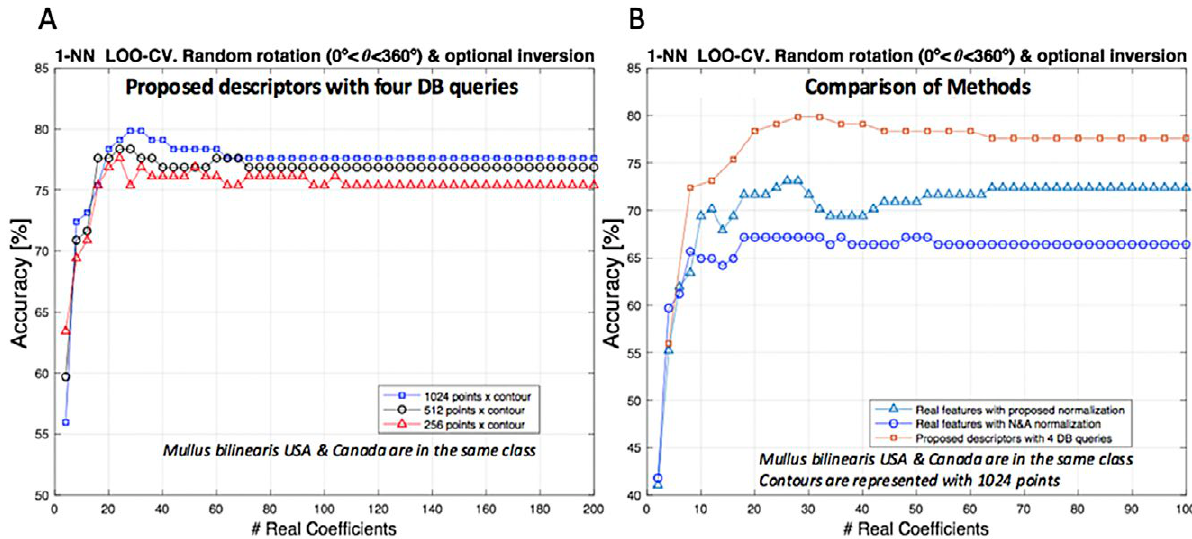
Fig. 8. – A, k -NN ( k =1) classification results with LOOCV for # real coefficients when the second scenario is in force. The proposed param- eterization applied to four related contour shapes achieves practically the same accuracy as in the first scenario. B, k -NN ( k =1) classification results with LOOCV for # real coefficients for all full invariant methods described in the